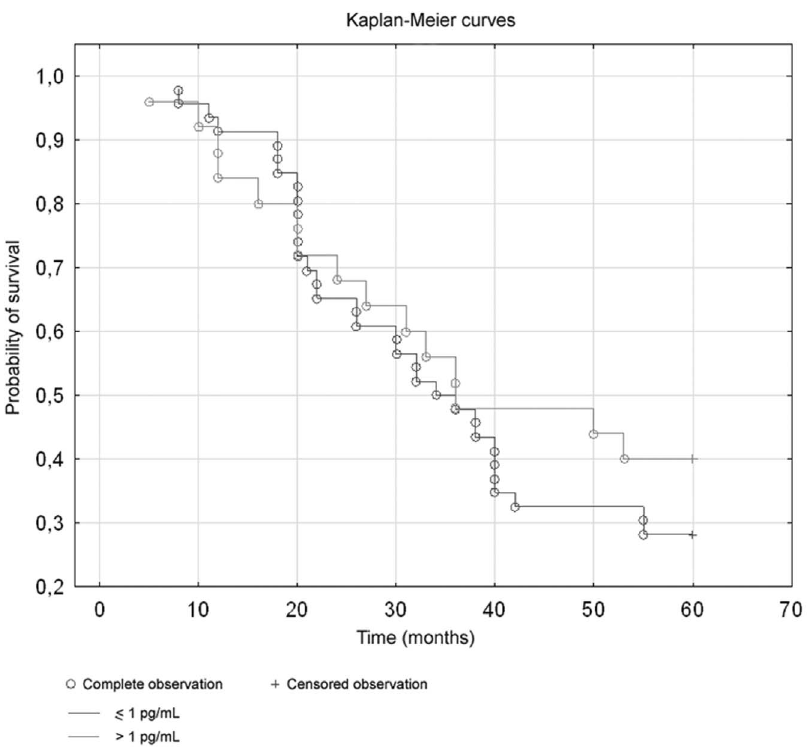
Figure 2. Survival curves in relation to inhibin A levels (p=0,46, log-rank test).